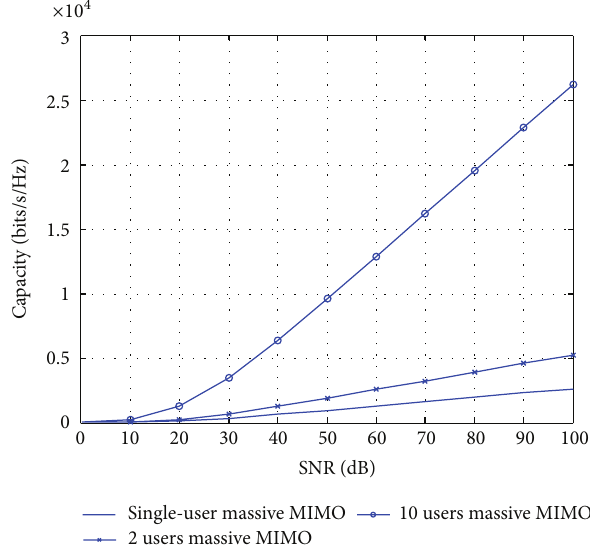
Figure 1: Capacity curve for large scale multiuser MIMO systems with 100 antenna elements at the